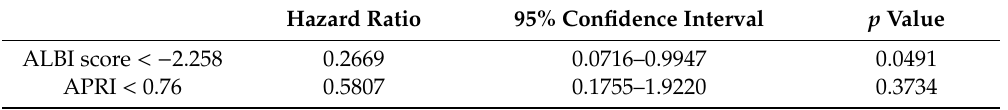
Table 3. Cox proportional hazard ratio analysis for transplant-free